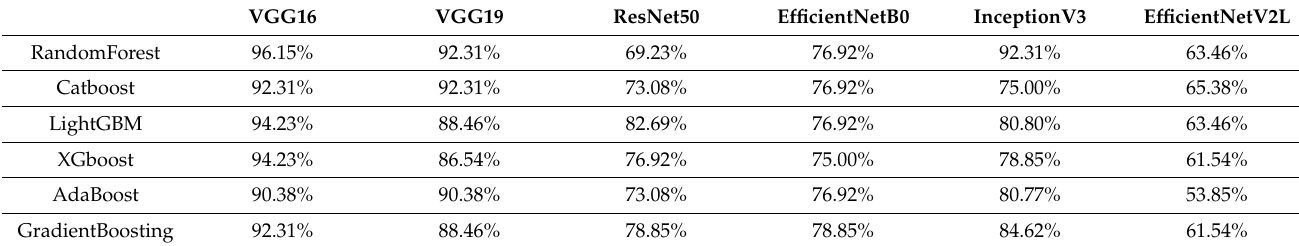
Table A17. Accuracy of each model combination for blue diamonds.